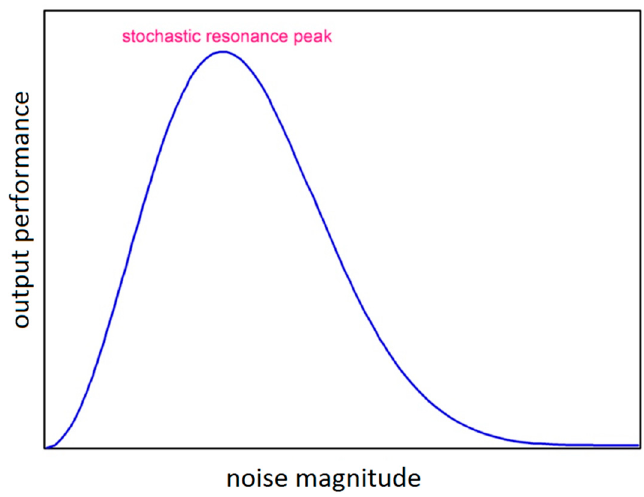
Figure 3. Typical curve of output performance as a function of input noise magnitude, for systems capable of stochastic resonance.